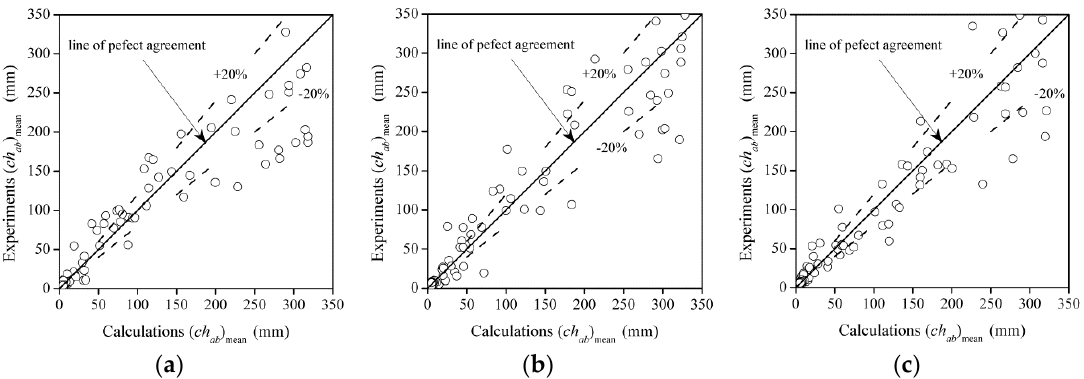
Figure 12. Measured air bubble chord length as a function of the air concentration. The solid lines are determined from Equation (6). Upper nappe ( a ) ( h , b ) = (4.5 cm, 4.5 cm), θ = 0%. ( b ) ( h , b ) = (2.5 cm, 2.5 cm), θ = 10%; lower nappe ( c ) ( h , b ) = (4.5 cm, 4.5 cm), θ = 0%. ( d ) ( h , b ) = (2.5 cm, 2.5 cm), θ = 10%; side nappe ( e ) ( h , b ) = (4.5 cm, 4.5 cm), θ = 0%. ( f ) ( h , b ) = (2.5 cm, 2.5 cm), θ = 10%.